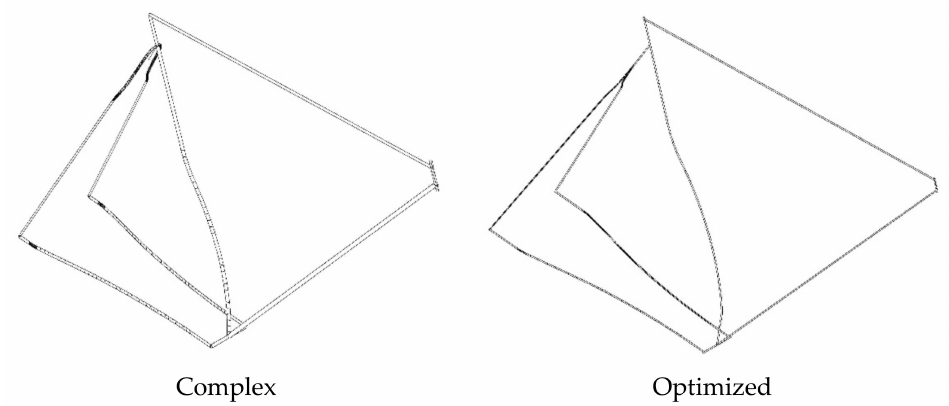
Figure 4. Sequence of simple spaceframe